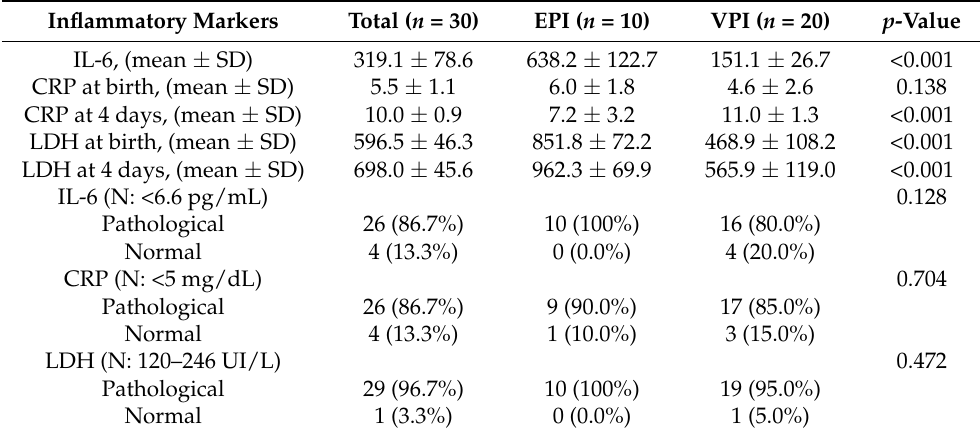
Table 2. Comparison of inflammatory markers by level of